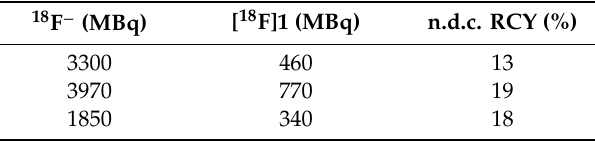
Table 1. Preparation of [ 18 F] 1 on a preparative